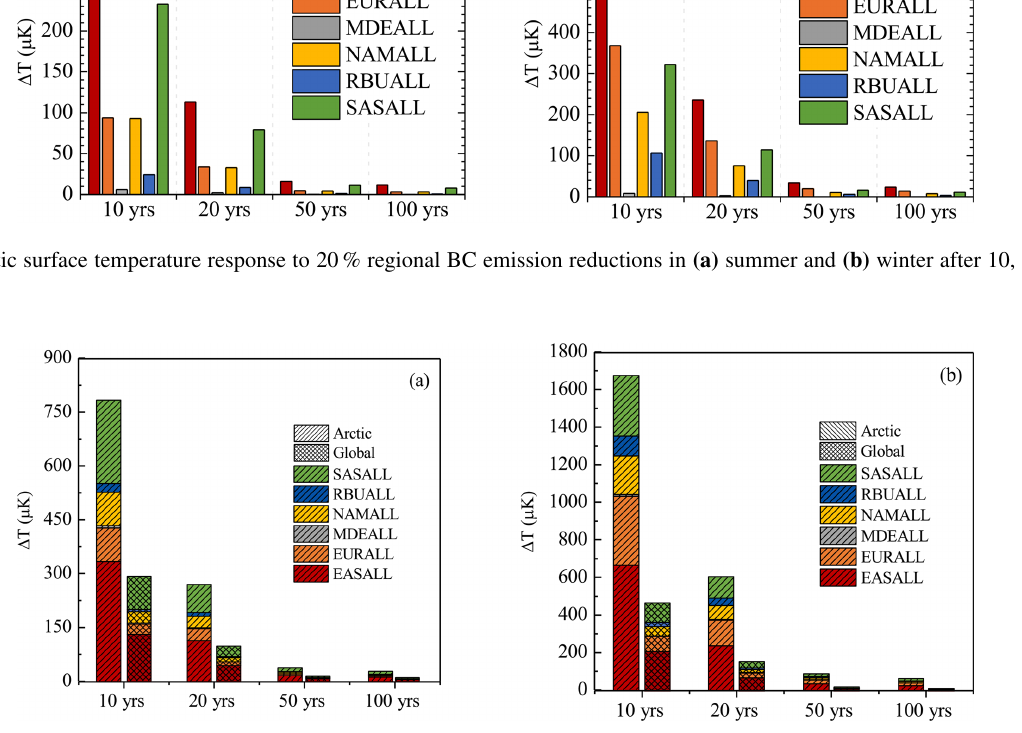
Figure 9. Global and Arctic surface temperature responses to 20% regional BC emission reductions in (a) summer and (b) winter after 10, 20, 50, and 100